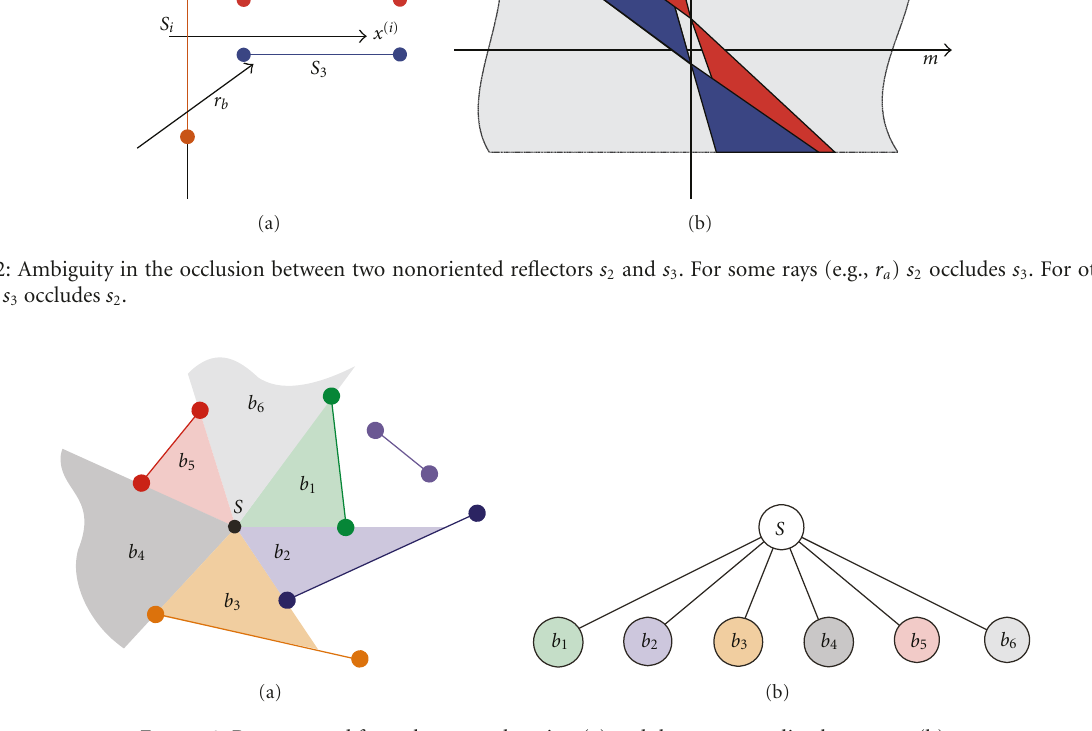
Figure 3: Beams traced from the source location (a) and the corresponding beam-tree